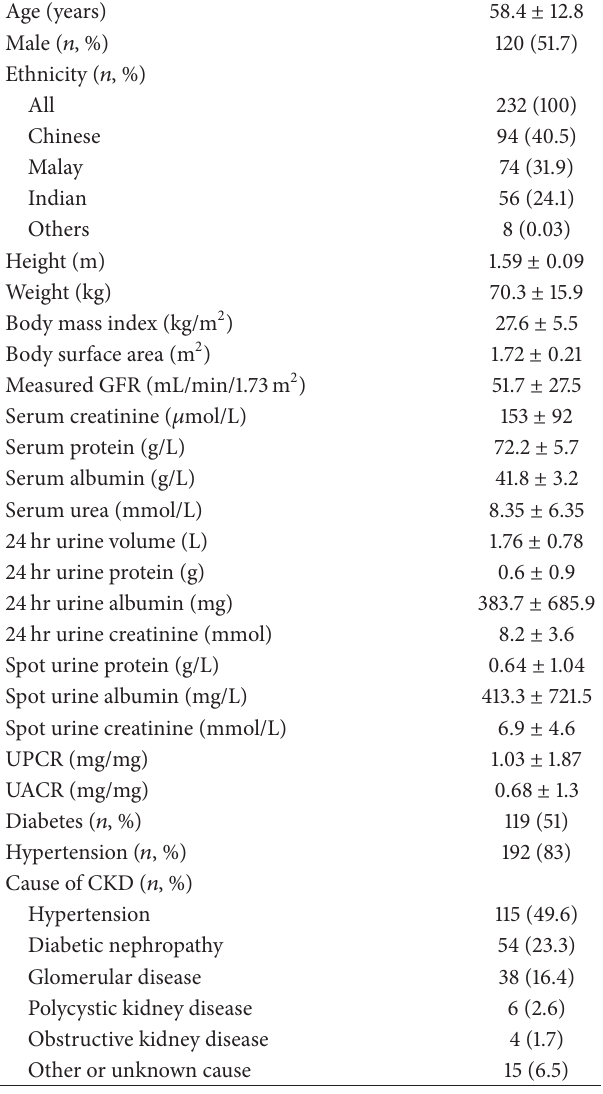
Table 1: Characteristics of